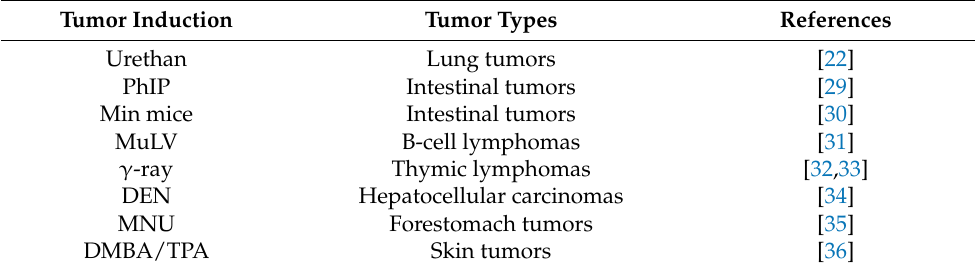
Table 1. Tumor types examined with MSM/Ms (MISHIMA/Mishima). Tumor